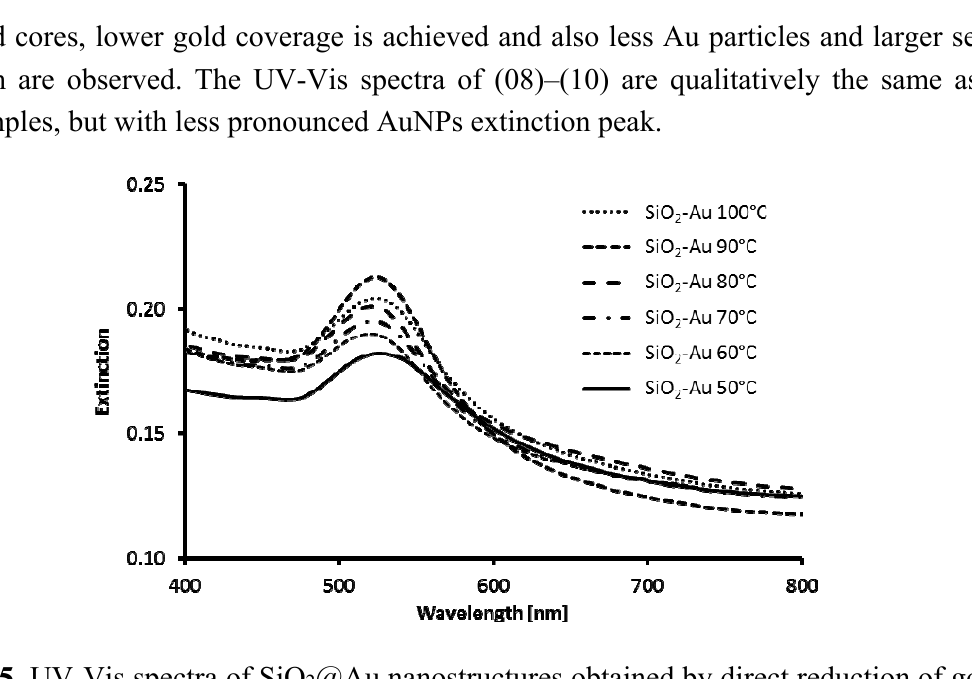
Figure 5. UV-Vis spectra of SiO 2 @Au nanostructures obtained by direct reduction of gold salts on functionalized SiO 2 particles at various temperatures: ( 01 ) 100 °C; ( 02 ) 90 °C; ( 03 ) 80 °C; ( 04 ) 70 °C; ( 05 ) 60 °C; and ( 06 ) 50 °C.